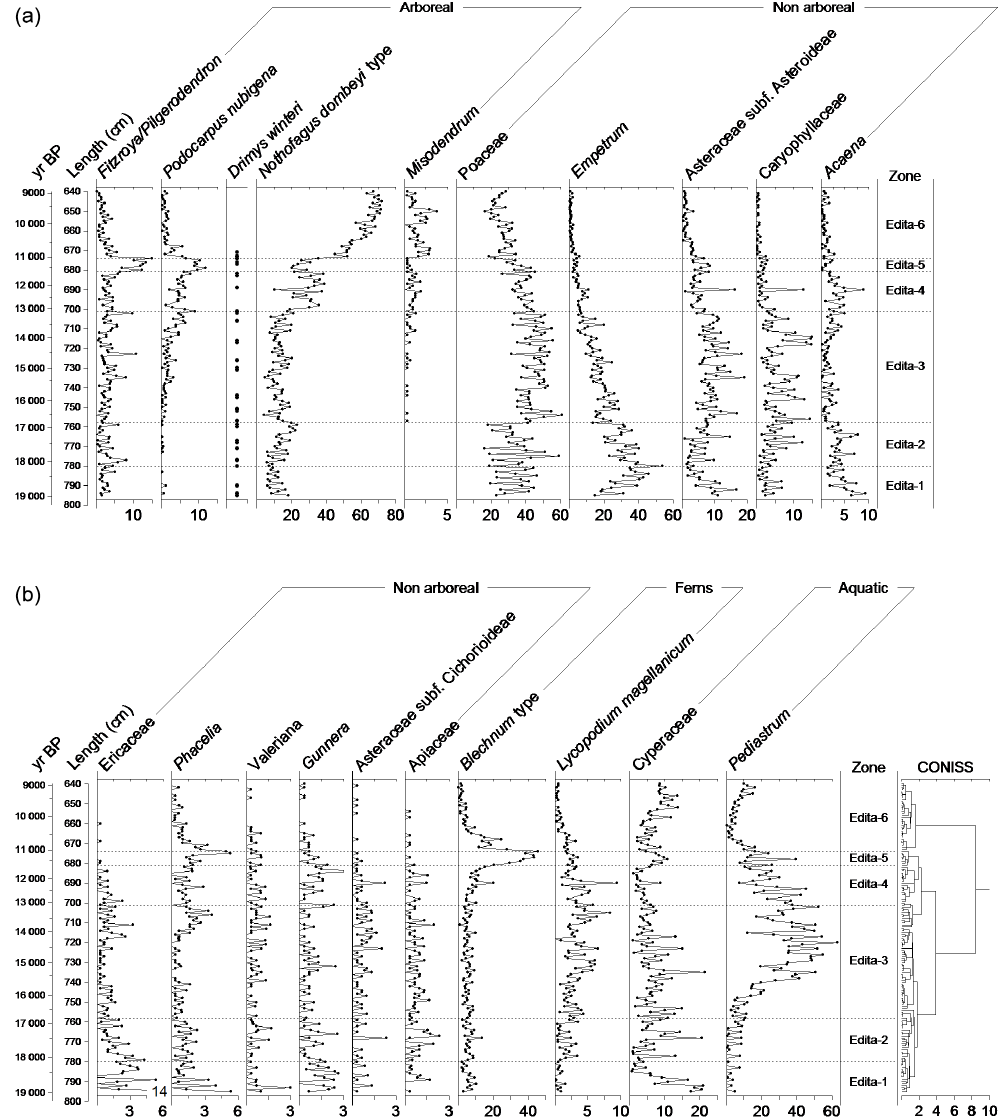
Figure 4. Percentage pollen diagrams from the Lago Edita core. The labels on the right indicate the identity and stratigraphic span (dashed horizontal lines) of each pollen assemblage zone. The black dots indicate the presence of Drimys winteri pollen grains, normally <